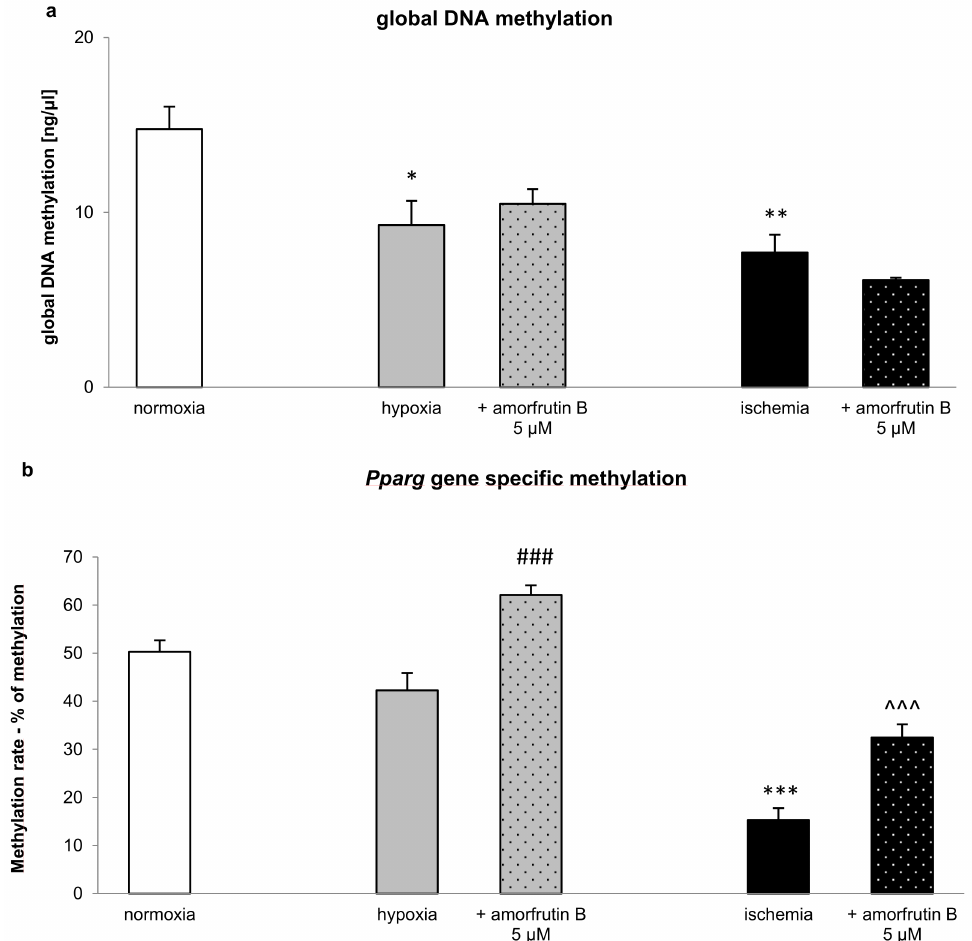
Figure 9. Hypomethylation of global DNA ( a ) and alterations in gene specific methylation of Pparg ( b ) after hypoxia or ischemia and exposure to amorfrutin B (5 µ M). The results are presented as a mean ± SEM. There were 3 independent experiments, consisting of 6 replicates per group. * p < 0.05, ** p < 0.01, and *** p < 0.001 compared to the control group, ### p < 0.001 compared to the cultures exposed to hypoxia, ˆˆˆ p < 0.001 compared to the cultures exposed to